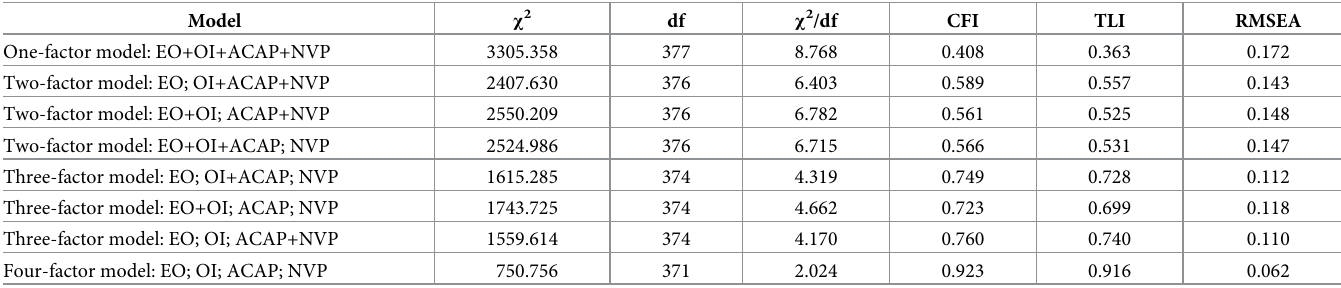
Table 2. Model fit statistics for measurement models.